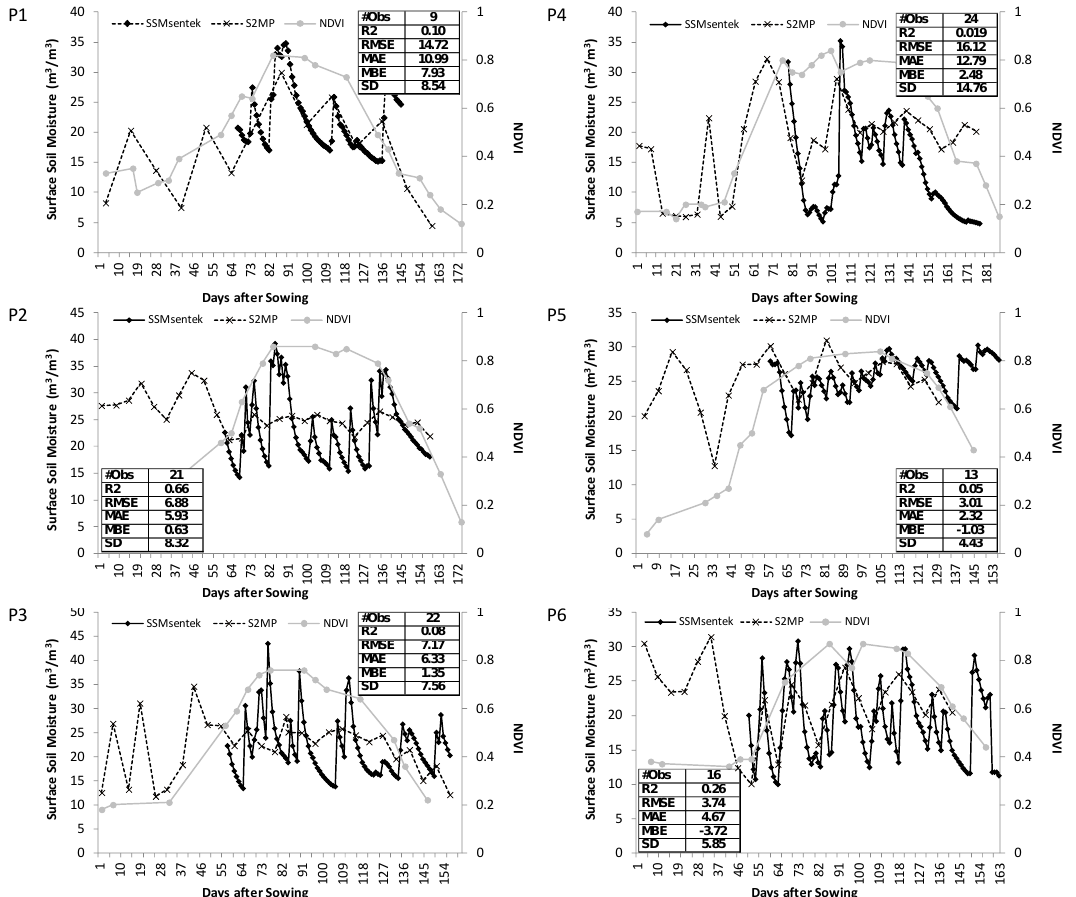
Figure 2. Time series of surface soil moisture after sowing, for six maize plots. The NDVI is shown in light gray. The tabular insets indicate the number of S 2 MP observations (#obs), as well as the statistical parameters used to compare S 2 MP with surface soil moisture (SSM) Sentek : the determination coefficient (R 2 ), the root mean squared error (RMSE), the mean absolute error (MAE), the mean bias error (MBE) and the standard deviation (SD), the last third in m 3 · m 3 − 1